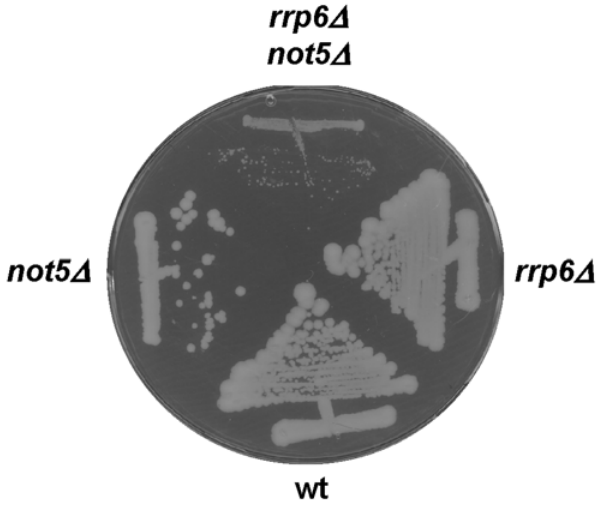
Figure 2. Synthetic growth phenotype when deletions of RRP6 and NOT5 are combined. The indicated strains were streaked on YPD plates and let to grow for several days at 30 u C.